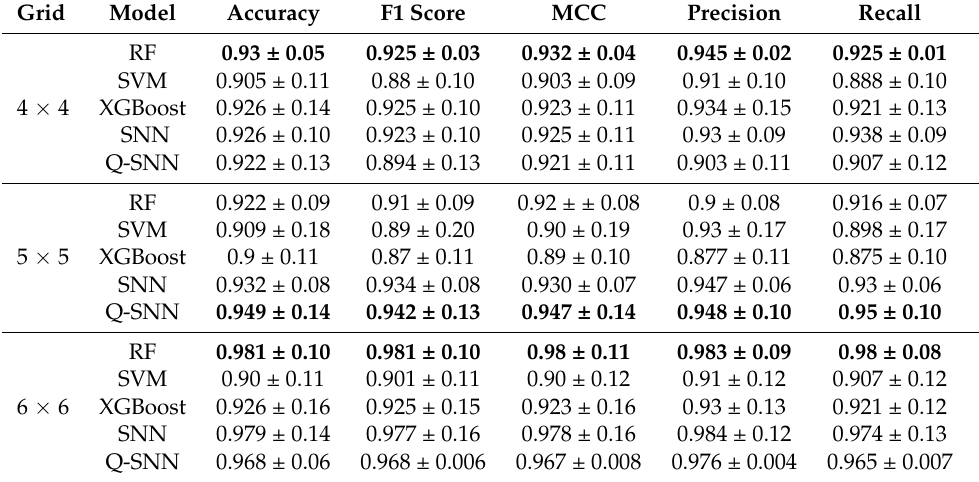
Table 6. ML models’ quality evaluation metrics. The results from the best model per grid case are highlighted in bold.